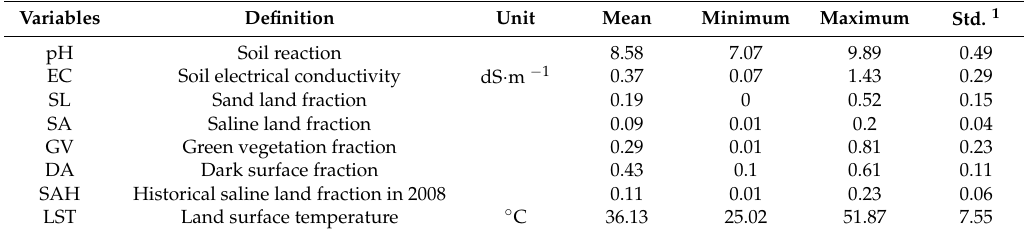
Table 2. Variables’ descriptive statistics in this study (38